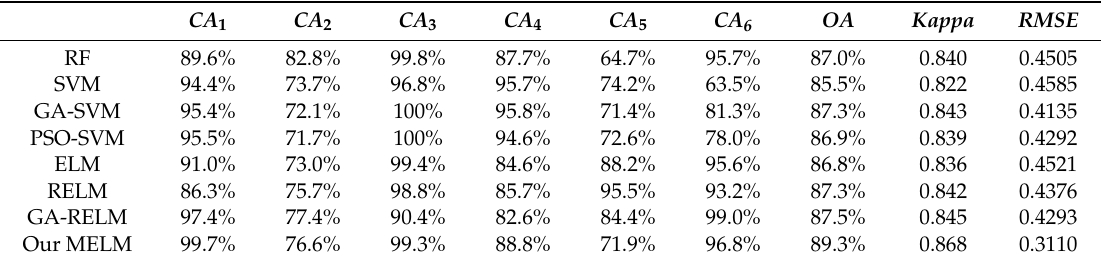
Table 4. The test set evaluation indexes of each classifier in the Z1 area.